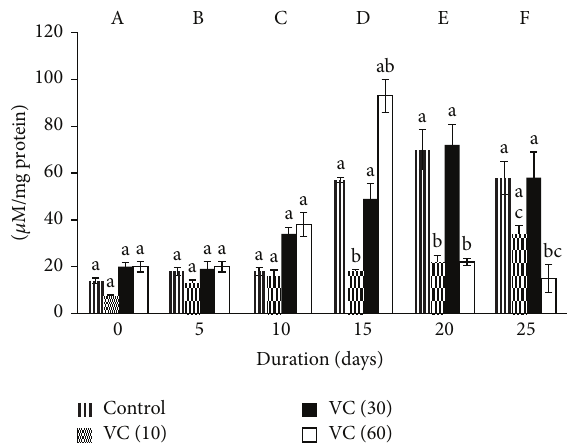
Figure 5: Advanced oxidation protein products in plasma isolated from stored blood. Values are mean ± SE of five animals/group. VC (10): vitamin C (10mM), VC (30): vitamin C (30 mM), and VC (60): vitamin C (60 mM). Two-way ANOVA was performed between the groups and subgroups. A–F values between the groups are significantly different at 𝑃 < 0 . 05. Changes within the groups are represented in lower case. Those not sharing the same letters are significantly